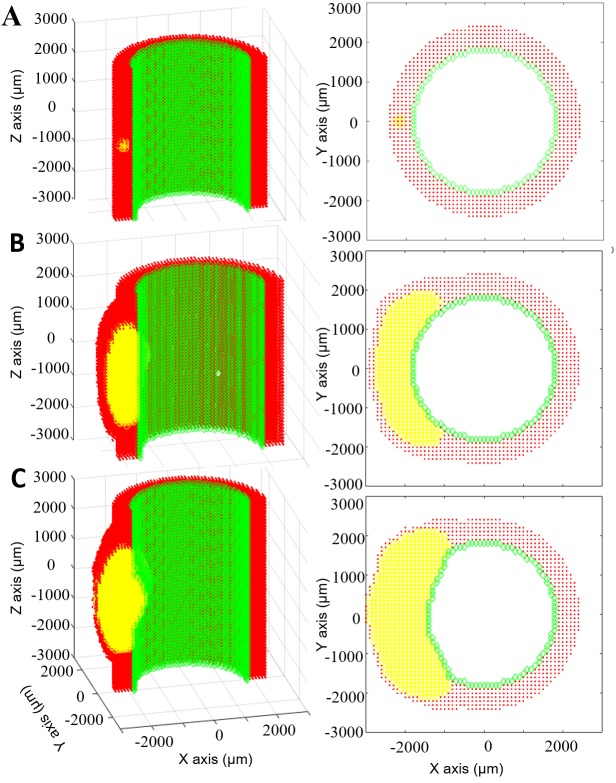
Eccentric plaque growth and remodeling prediction.Longitudinal (left) and corresponding transverse (right) views of an evolving artery where ECs, ACs and leukocytes are represented by green, red and yellow respectively. A) Initially the artery is impregnated with 15 leukocytes. B) At 6 months the plaque area is 40% of the lumen area and will start growing inside lumen according to Glagov’s phenomenon. C) At 7 months the plaque has grown inward and outward, changing the luminal geometry.